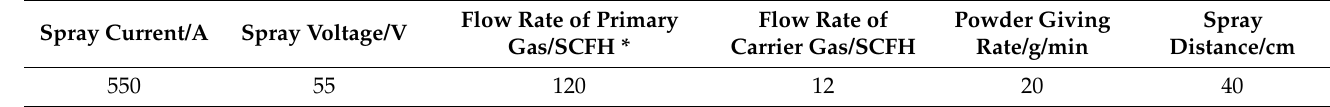
Table 1. Parameters used in plasma treatment.